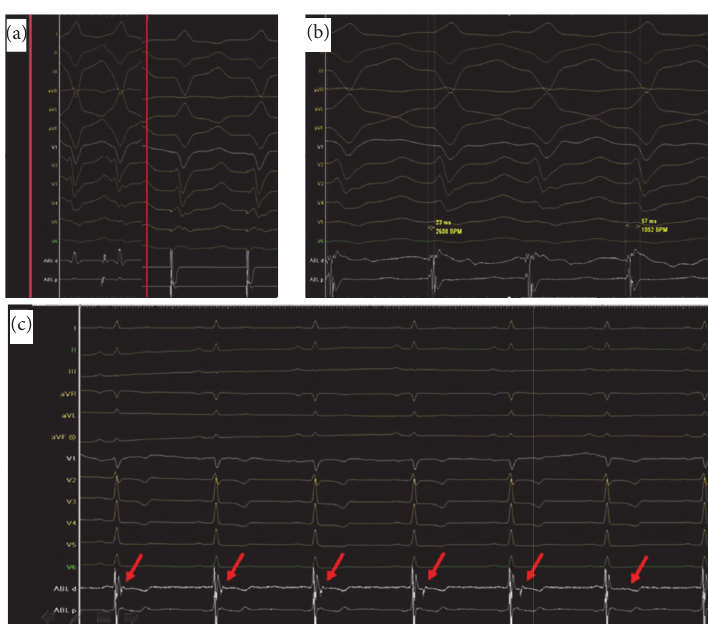
Figure 2: (a) Pacing mapping showed that the morphology of pacing QRS complex is identical to the QRS complex of clinical IVT (inside the red box). (b) A complex fractionated, high frequency potential with long duration of 57 milliseconds, preceding the QRS onset of the IVT by 23 milliseconds. (c) A conduction block of Purkinje potential (red arrow) was observed during the sinus rhythm after successful ablation during the first